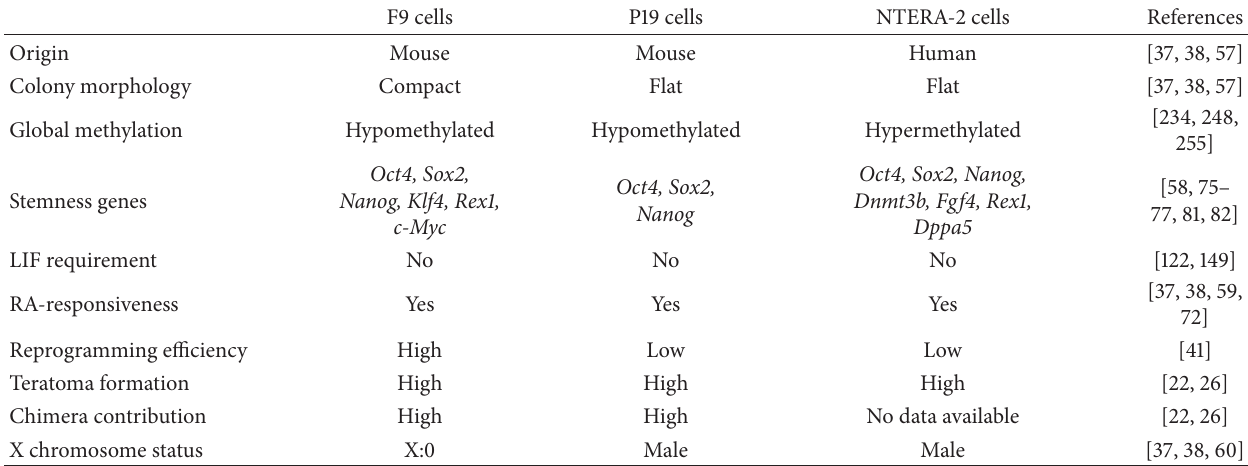
Table 1: Key features of ECC